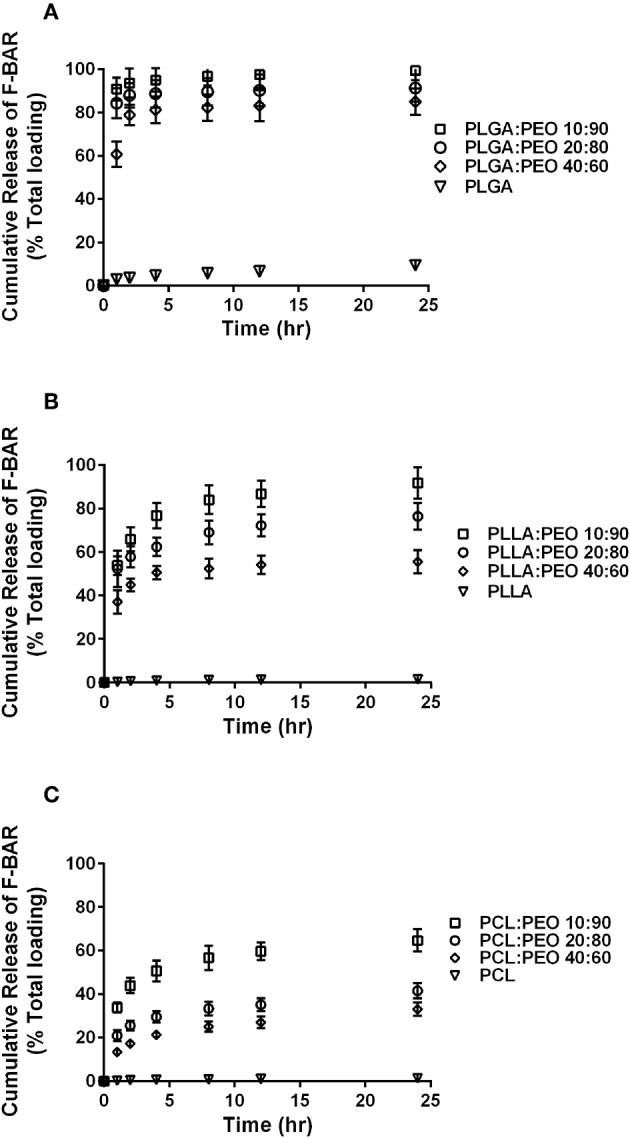
The cumulative release of F-BAR from the non-blended and PEO-blended formulations as a function of hydrophobic polymer type (A) PLGA, (B) PLLA, or (C) PCL and PEO ratio in each blend. The release of encapsulated BAR increases with an increase in PEO fraction. PLGA and PEO blends exhibit the most significant and rapid F-BAR release, relative to PLLA and PCL blends. For all polymer types, the 10:90 blends show the greatest release of BAR as compared to the 20:80 and 40:60 formulations at any given time point. PLGA:PEO (10:90) fibers provide the highest amount of BAR release across formulations. Data represent the mean ± standard deviation (n = 3) of three independent experiments.